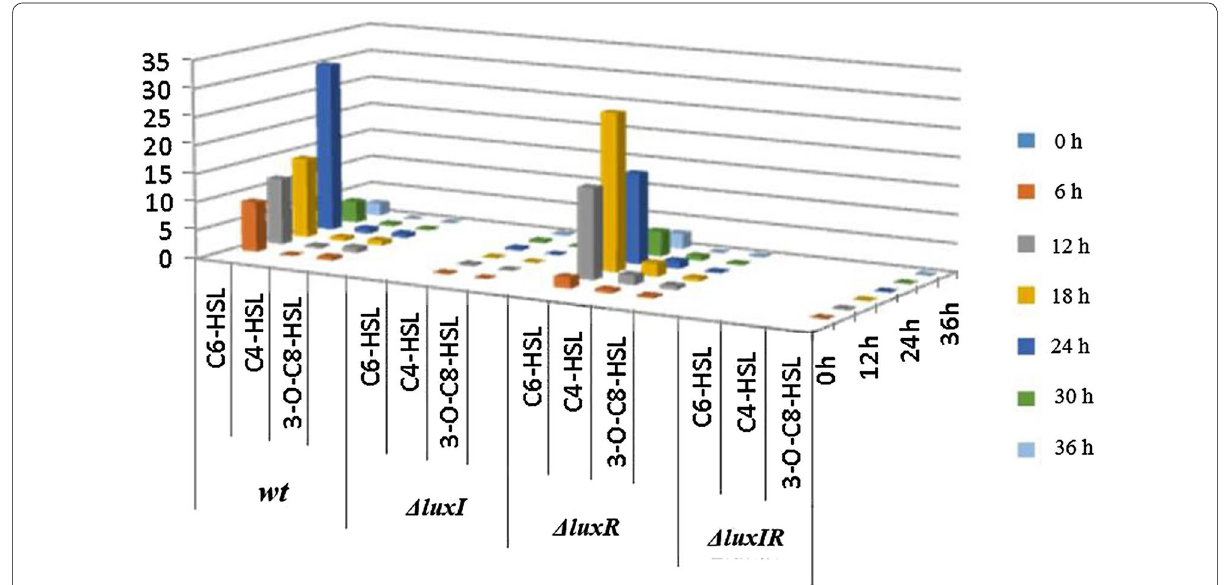
Fig. 2 The AHL extracts of wild-type H. alvei H4 and its Δ luxI, Δ luxR, Δ luxIR mutants at different times were detected by